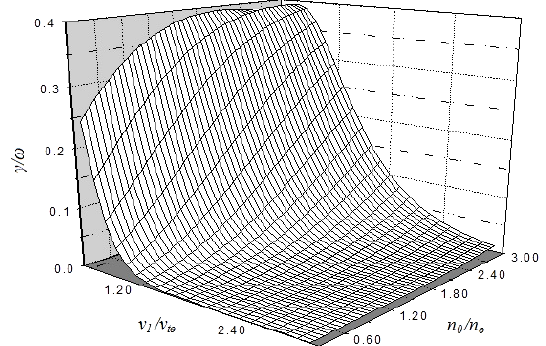
Fig. 3. Dependence of EMR damping on the non-equilibrium parameter of solid-state